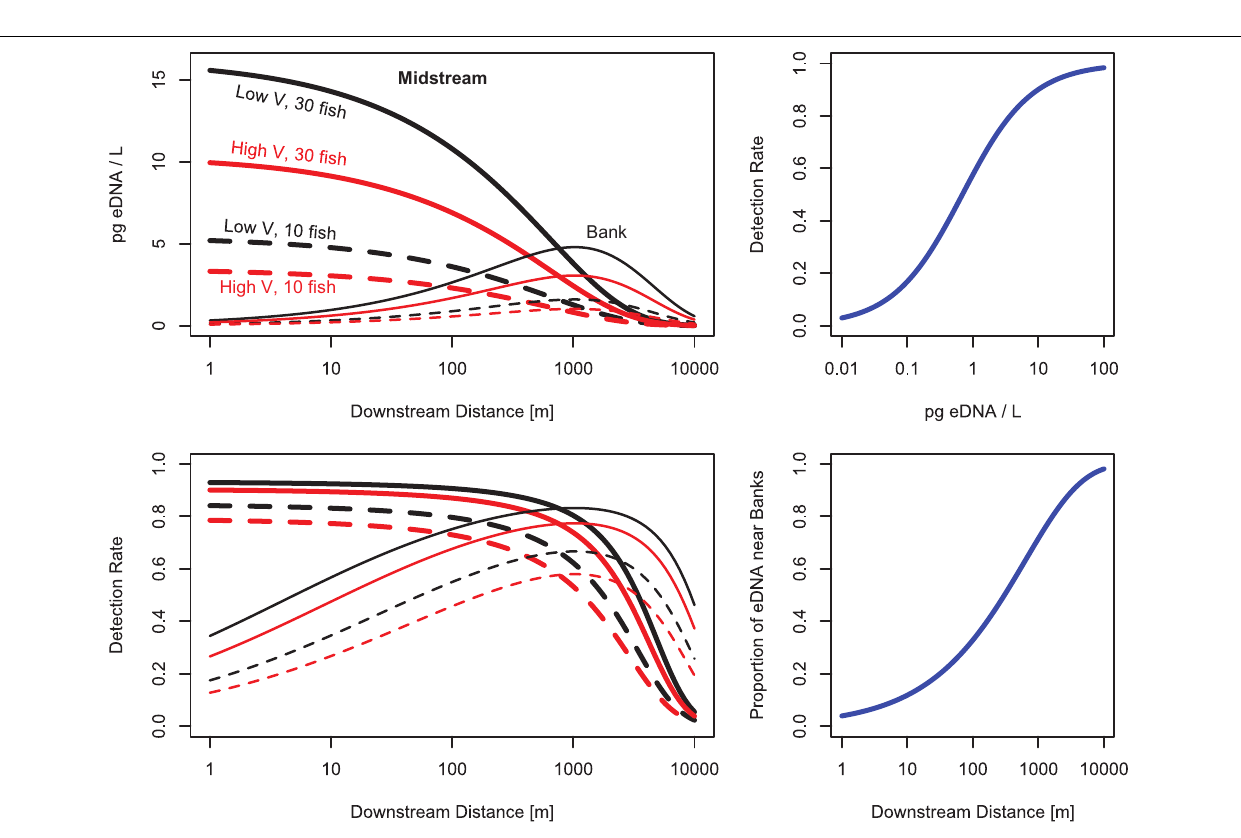
Frontiers in Ecology and Evolution |